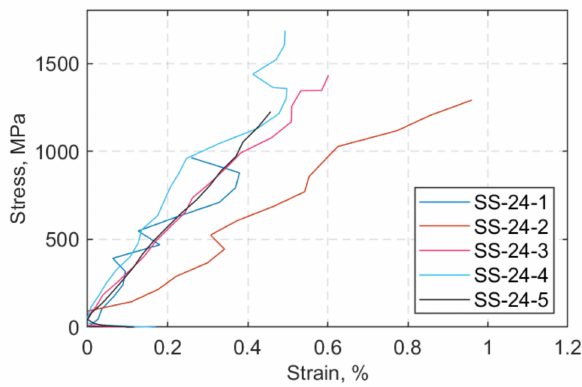
Figure 15. Stress (Mpa) vs. strain (%) at 24 ◦ C.